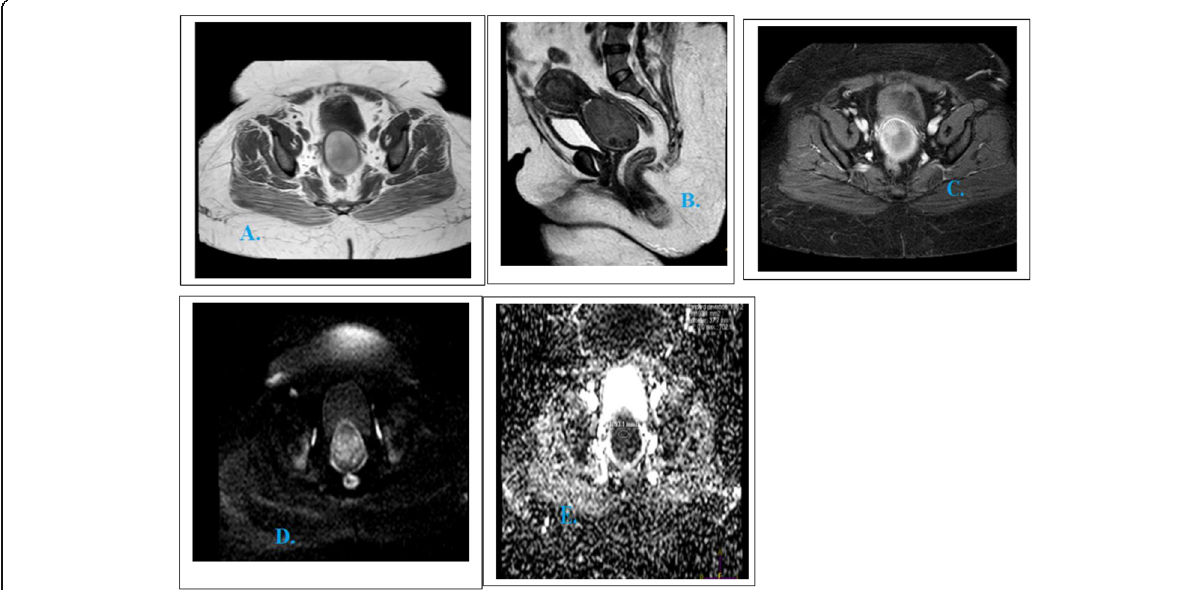
Fig. 4 Female patient 57 presenting with post-menopausal bleeding. a – c Axial T1WI, sagittal T2WI, and post-contrast axial image revealed the presence of a rather well defined heterogeneous soft tissue mass lesion filling the endocervical canal measuring 5.8 × 5.2 × 8 cm in (AP, transverse, CC) dimensions, with blurring of posterior low signal intensity serosa of the cervix denoting possibility of parametrial invasion. It elicits intermediate signal on T2 and hyper intense signal on T1 with enhancing mural nodule. High signal on DWI ( d ) and low signal on the corresponding ADC maps ( e ). ADC value was (0.831 × 10 − 3 mm 2 /s). Finding suggestive of malignant lesion. Pathology revealed leiomyoma with chronic cervicitis